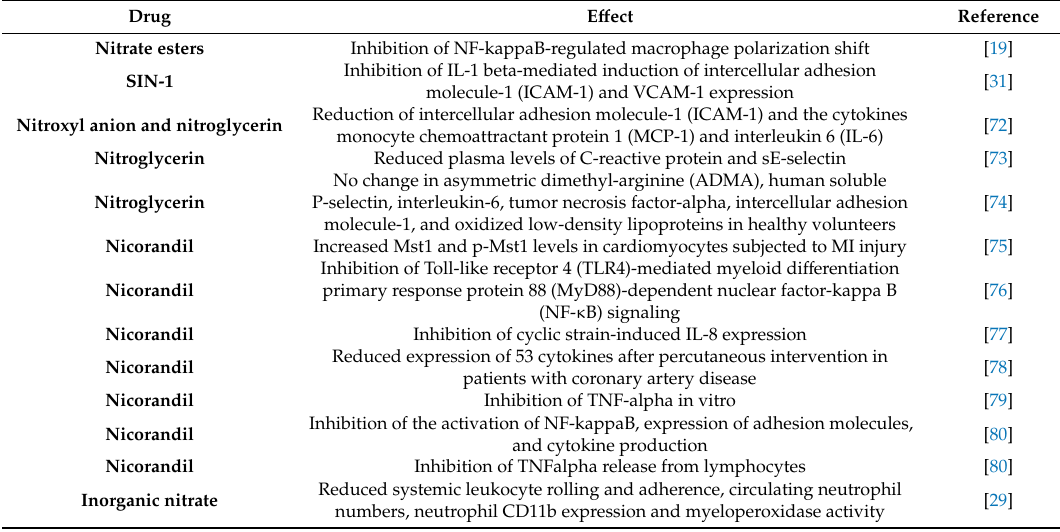
Table 1. NO donors and their e ff ects on